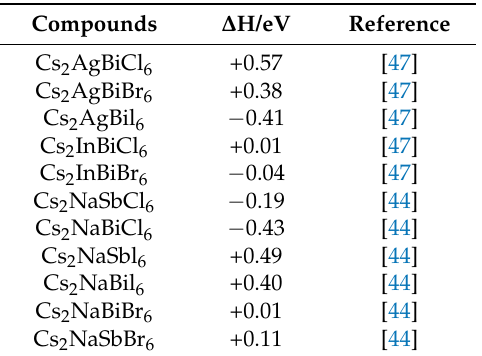
Table 1. Calculated values of enthalpy of formation for various double halide perovskites.